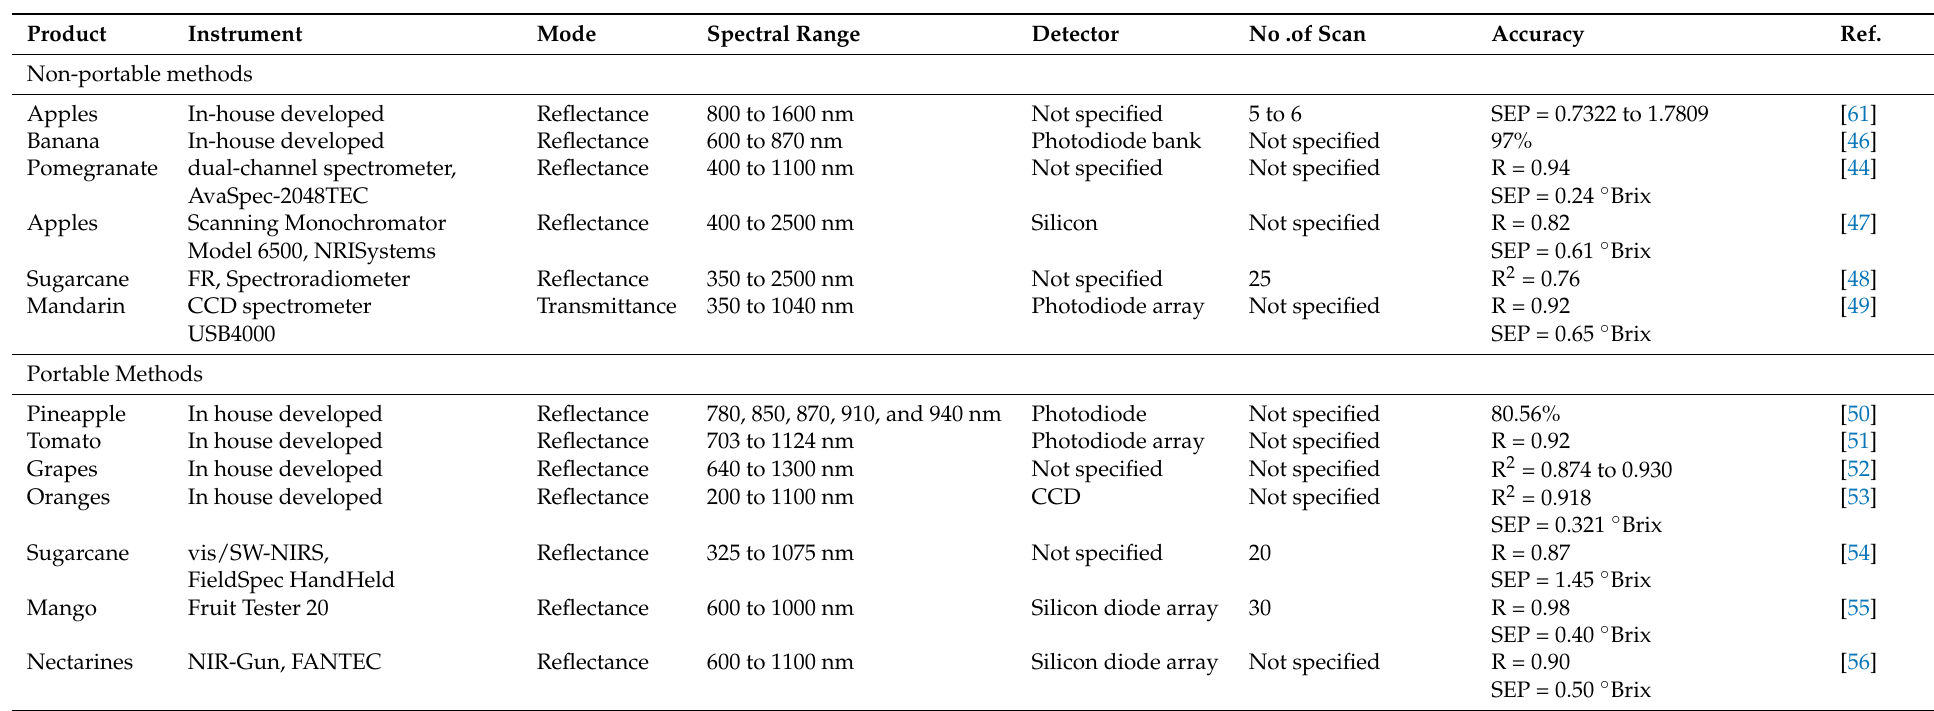
Table 4. Summary of NIR methods reported in the